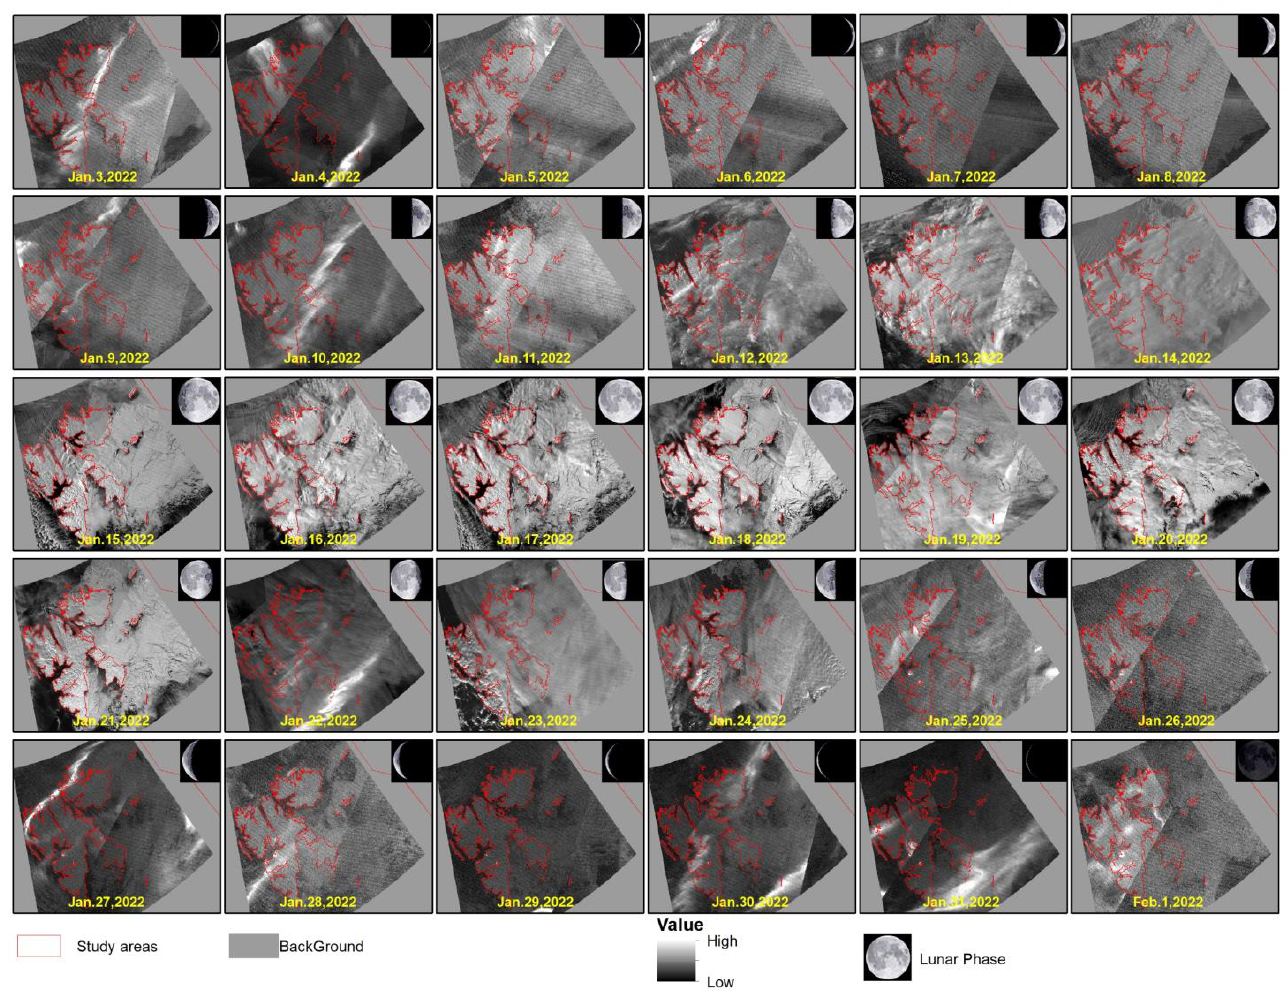
Figure 3. Moonlight remote sensing images during lunar December 2021.